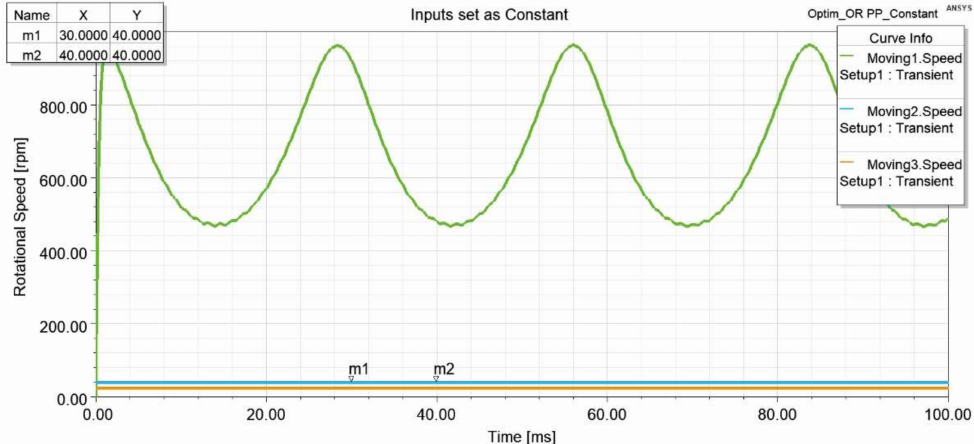
Figure 14. Rotational speed when the inner rotor (output) is set as constant.